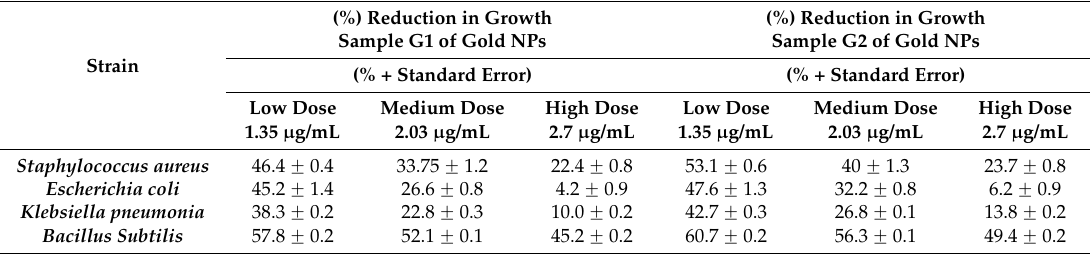
Table 1. Antibacterial effect on Staphylococcus aureus ( S. aureus ), Escherichia coli ( E. coli ), Klebsiella pneumonia ( K. pneumonia ) and Bacillus subtilis ( B. subtilis ) for low, medium and high doses of gold nanoparticles (NPs) of two sizes, sample named as G1 and G2. Strain (%) Reduction in Growth Sample G1 of Gold NPs Strain